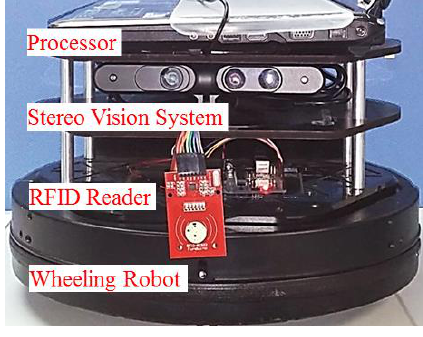
Figure 2. Proposed patrol robot.